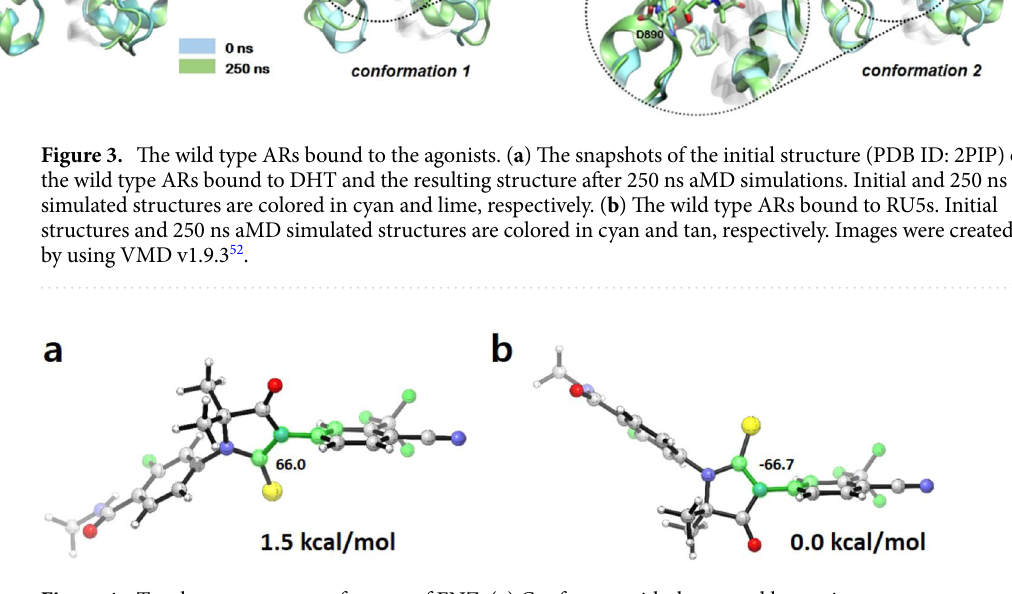
Figure 4. Two lowest energy conformers of ENZ. ( a ) Conformer with the second lowest in energy ( conformation 1 ) and ( b ) the lowest in energy conformation ( conformation 2 ). The dihedral angles of the four highlighted atoms (C-C-N-C) are shown. Images were created by using CYLView v.1.0.561 56